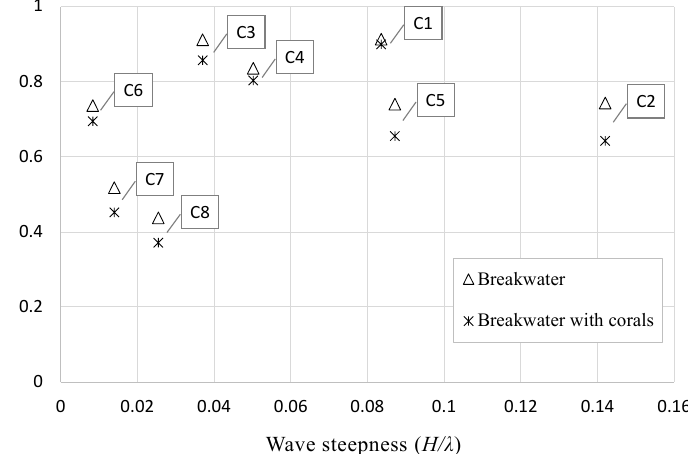
Figure 5. Wave-transmission rate for the two configurations of the reef model under a water depth h = 0.65 m.